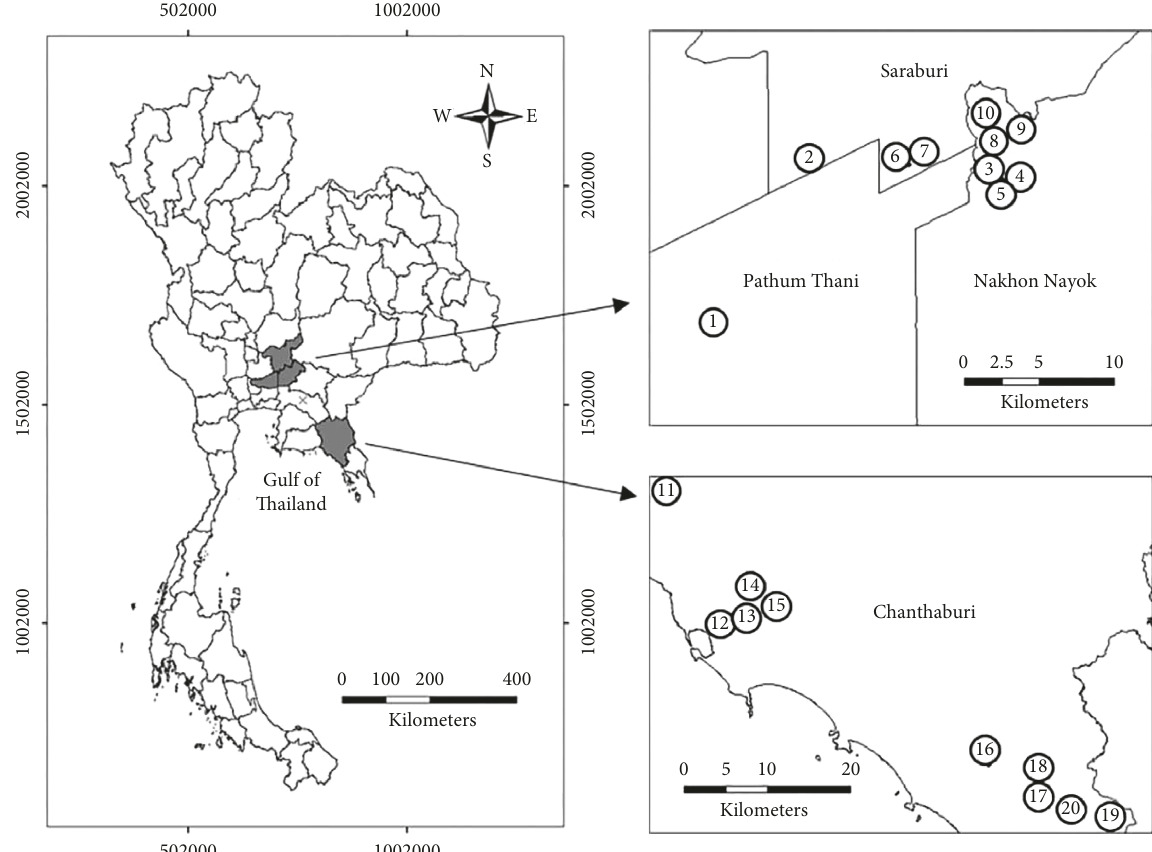
Figure 1: Sampling locations of acid sulfate soils under oil palm planting areas in Central Plain (ID 1–10) and Southeast Coast (ID 11–20) regions,